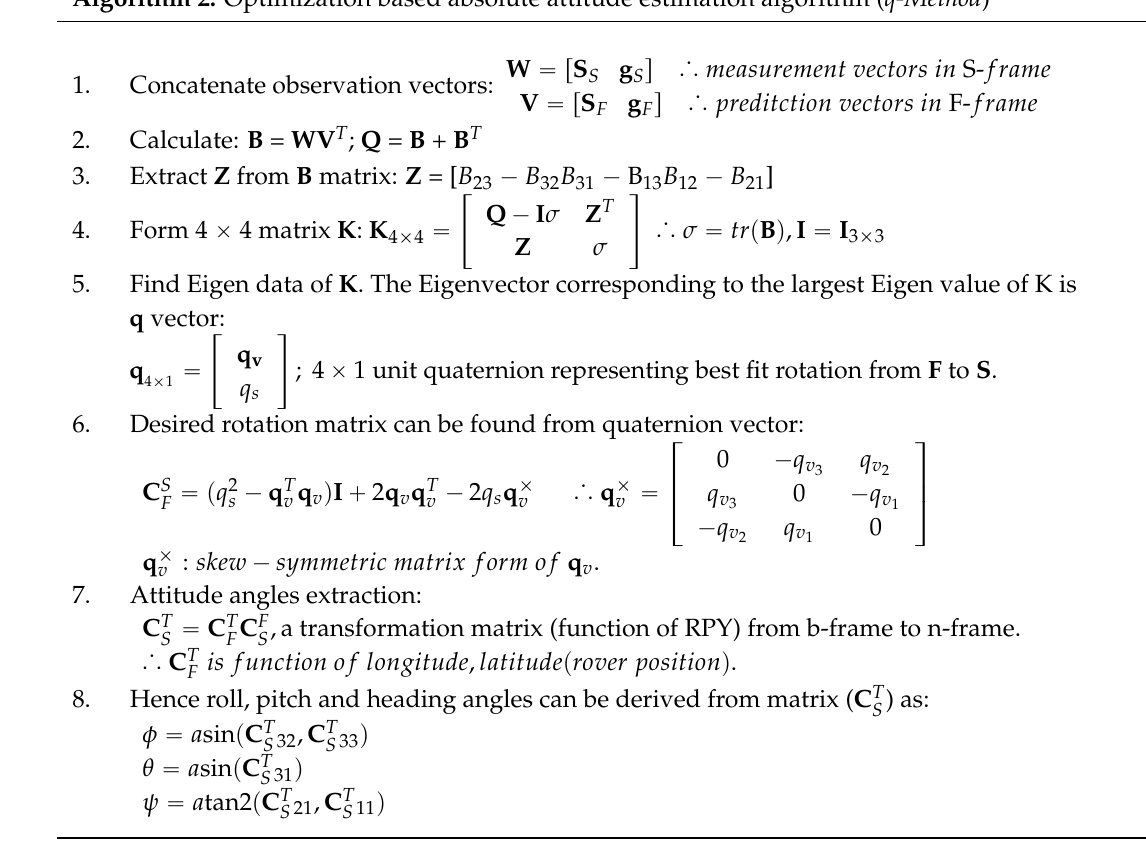
Algorithm 2. Optimization based absolute attitude estimation algorithm ( q-Method